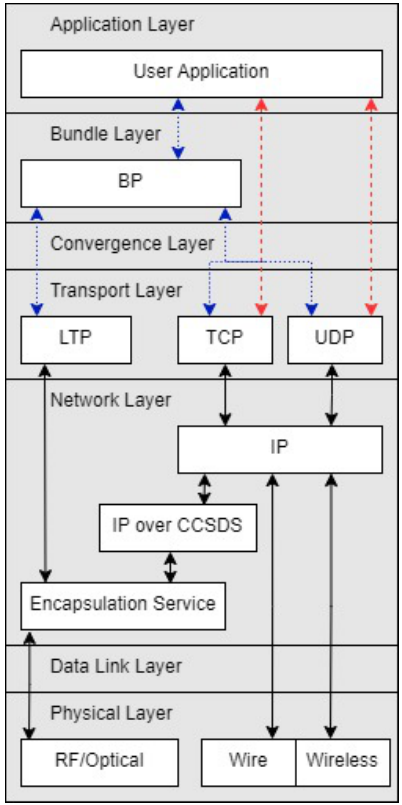
Figure 1. Bundle Protocol network stack. Blue dotted lines show OSI model layer 4 and up for a typi- cal DTN network stack. Red dashed lines show the typical layer 4 and up for Earth communications (without BP). Black solid lines show the underlying network